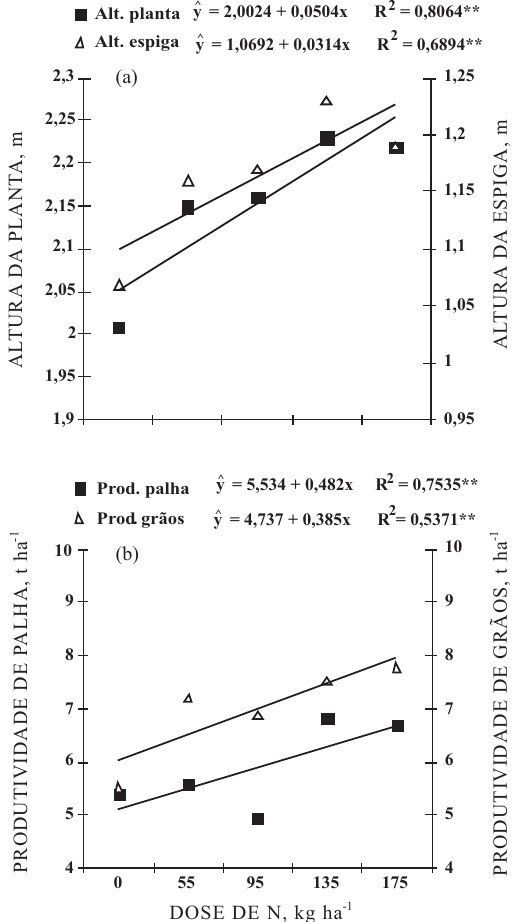
Figura 1. Altura da planta, altura da inserção da espiga (a), produtividade de palha e produtividade de grãos de milho (b), em função de doses de